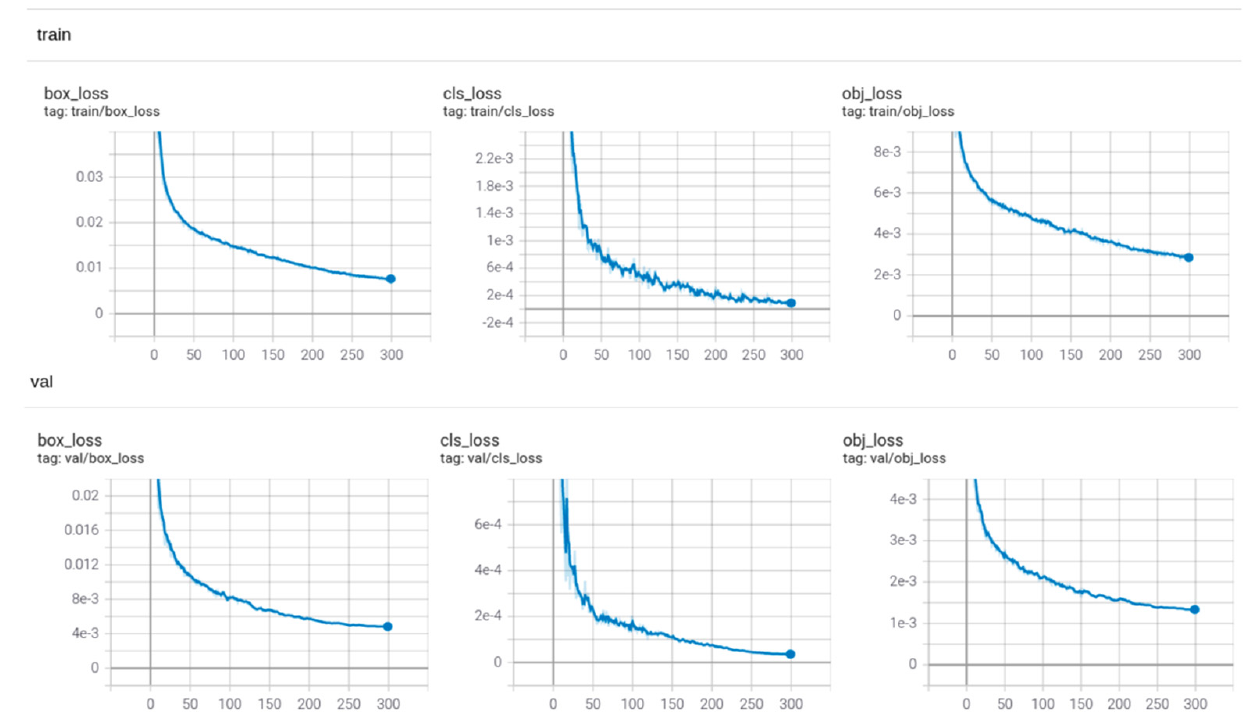
Figure 9. YOLOv4 training loss function curves.